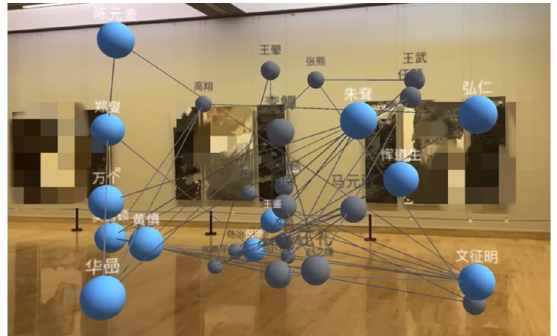
Figure 1. The application of the AR graph with data of Chinese painters in an art gallery (the text on top of the nodes are the Chinese names of the painters).